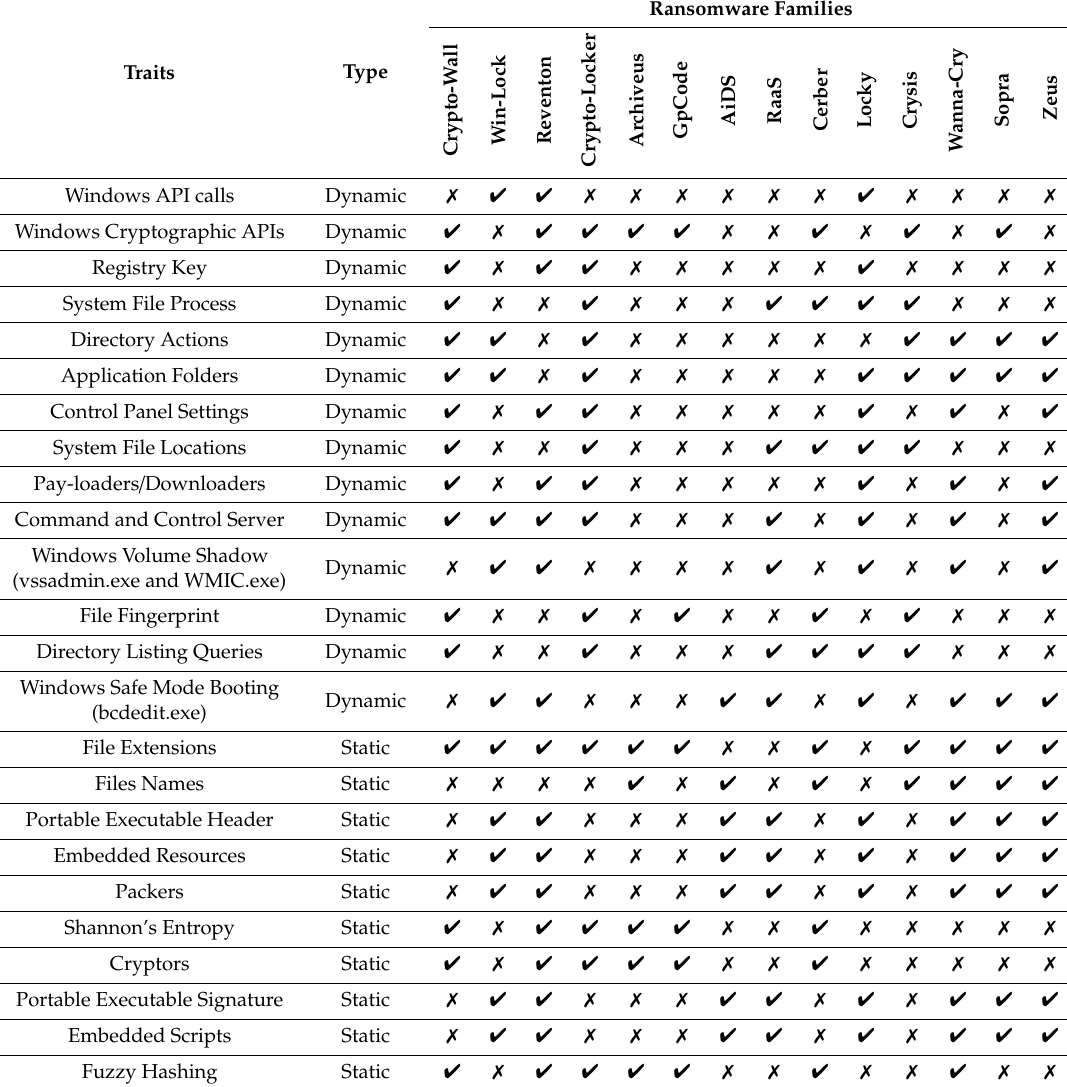
Table 4. Potential traits exploited by 0-Day versions of generic ransomware